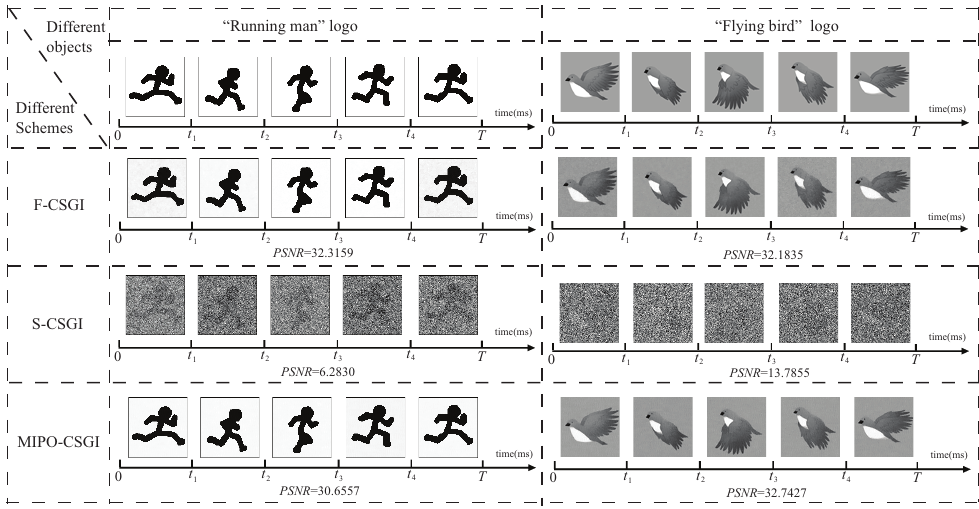
Figure 4. The numerical simulation results of different periodic state-changed objects using F-CSGI, S-CSGI, and MIPO-CSGI, where PSNR is presented